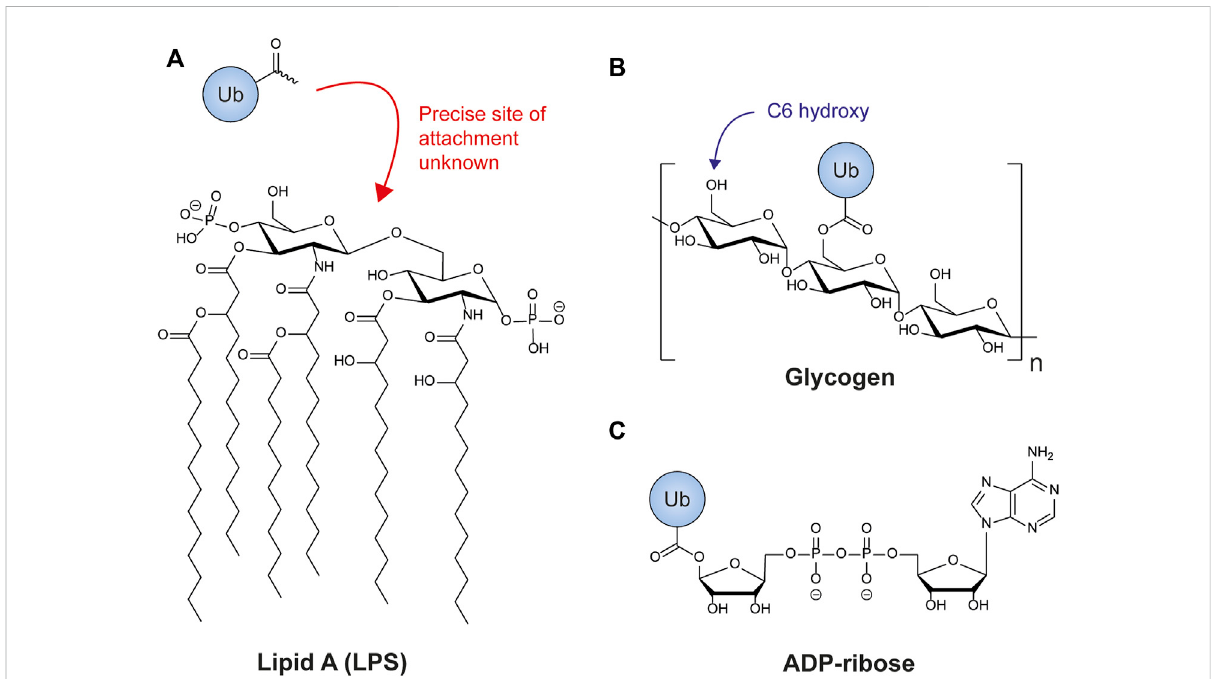
FIGURE 8 Non-proteinaceoussubstratesofubiquitylation. (A) TheLipidAcomponentofbacteriallipopolysacchariderepresentstheminimalsubstratefor RNF213-mediatedubiquitylationofLPS.Theprecisesiteofattachmentisnotyetknown. (B) Glycogenisahighlybranchedpolymerofglucose.Most glucoseunitsarelinkedtogetherby α (1,4)-glycosidicbondswithbranchesformedbytheintroductionofglycosidicbondsattheC6hydroxyposition every 8 – 12 glucose units. This C6 hydroxy group is also the target of HOIL-1-catalysed ubiquitylation of glycogen and related sugars. (C) The Deltex family E3 ligases can catalyze the conjugation of ubiquitin to ADP-ribose by means of an oxyester linkage between the 1 ′ -hydroxy group of ribose and ubiquitin ’ s C-terminus. This reaction requires all the components of the ubiquitylation cascade and involves no recognized ADP-